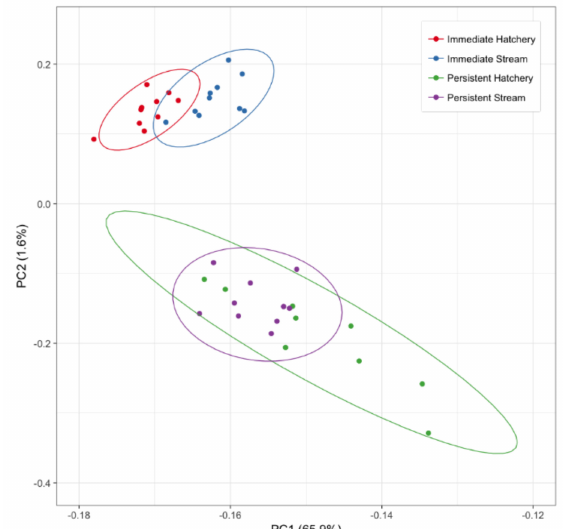
Figure 7. Principal components 1 and 2 of PCA describing variation in hepatic DNA methylation between rearing-group (hatchery or stream) and time-point ( Immediate (age-1) or Persistent